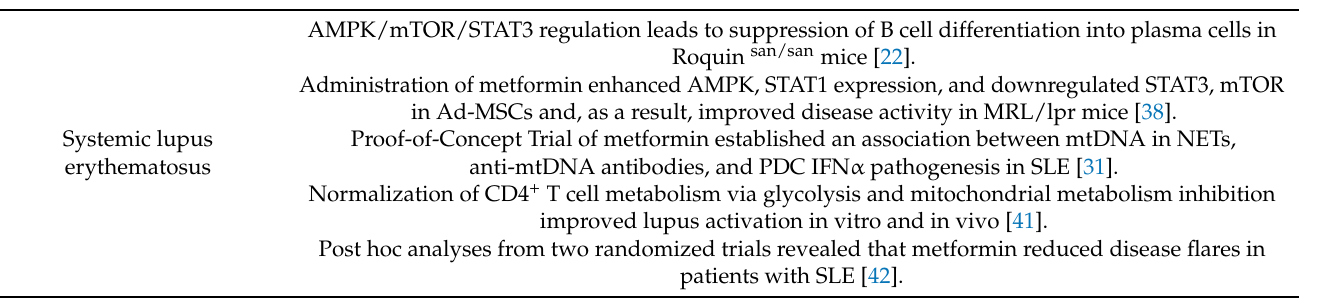
Table 1. Experimental animal and human studies concerning metformin and its anti-inflammatory effect in autoimmune and inflammatory disease.